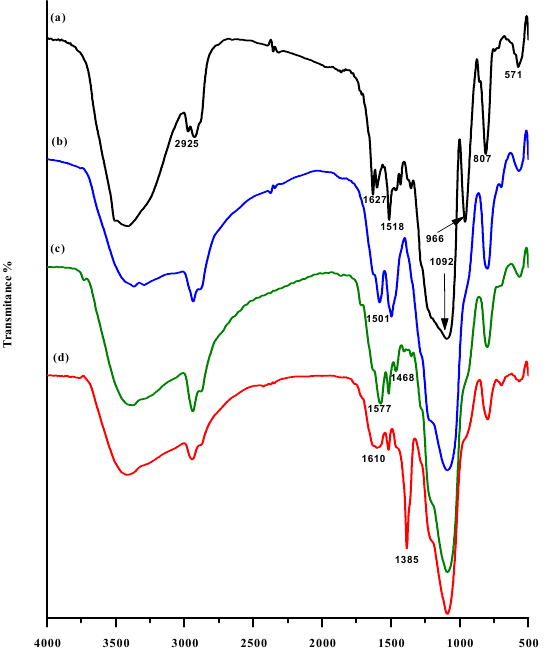
Figure 4. FT-IR spectra of; (a) as-synthesized IBN-1-Cur, (b) IBN-1-Cur-2N, (c) IBN-1-Cur-GA, and (d) IBN-1-Cur-CP.